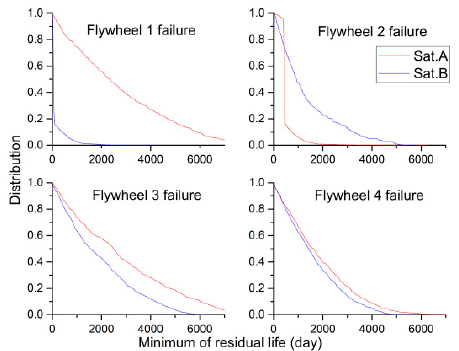
Figure 16. Life possibility distribution of a single flywheel.